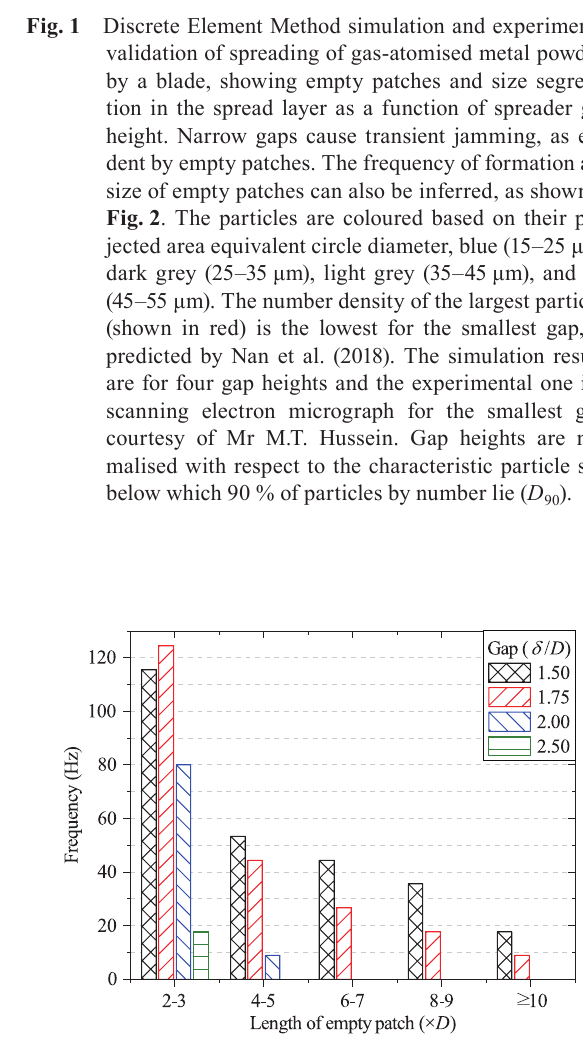
Fig. 2 Frequency of empty patches for each patch length as a function of gap height (Nan et al. (2018),